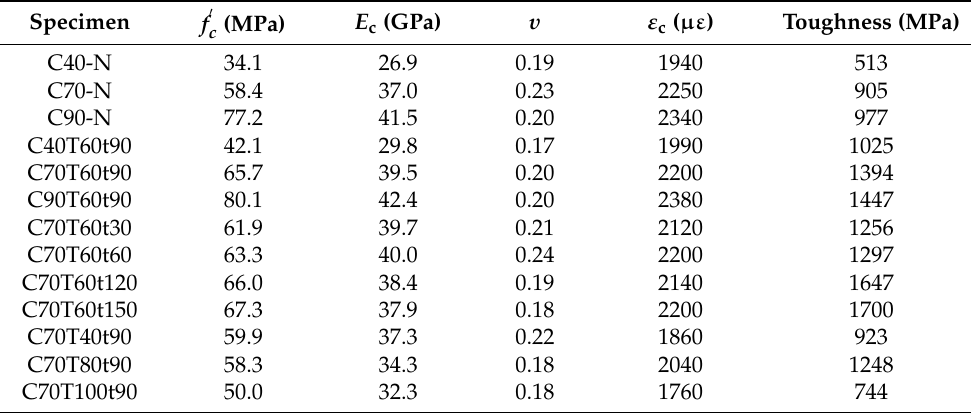
Table 2. SSC specimens and key experimental results.